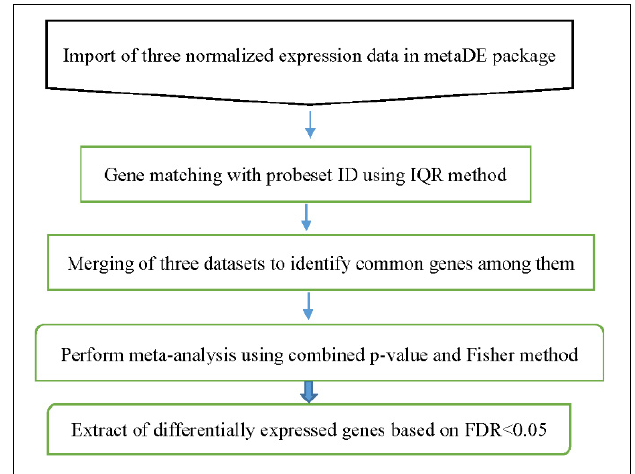
FIGURE 2 | Flowchart of the different steps of milk microarray meta-analysis based on combining P -value